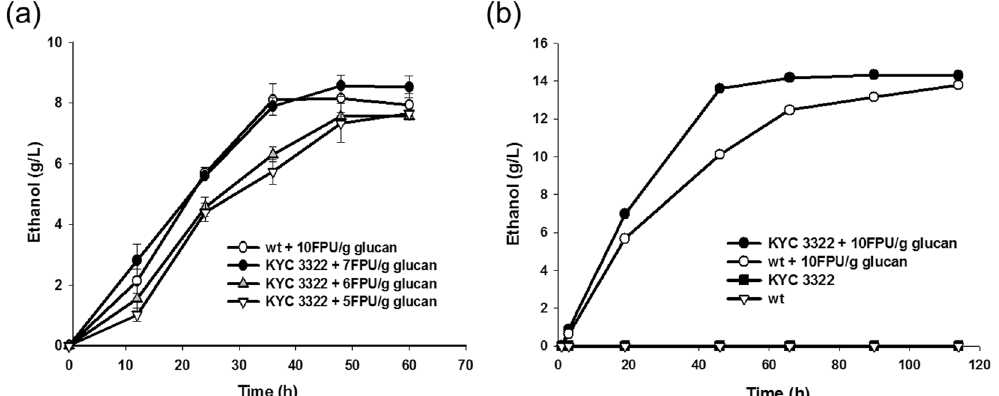
Figure 8. Ethanol fermentation from the cellulosic biomass using the KYC3322. ( a ) Ethanol production from pre-treated rice straw including 20 g glucan, using wild-type cells with 10 FPU Tec-mix/g glucan and the KYC3322 with 5–10 FPU Tec-mix/g glucan was compared in 100-mL flask culture. The values are the means of three repetitions of individual experiments ± standard deviations. ( b ) Ethanol production from pre-treated rice straw including 35 g glucan in 2-L fermentations by KYC3322 and wild-type yeast cells with 10 FPU Tec-mix/g glucan was analysed every 24 h for 5